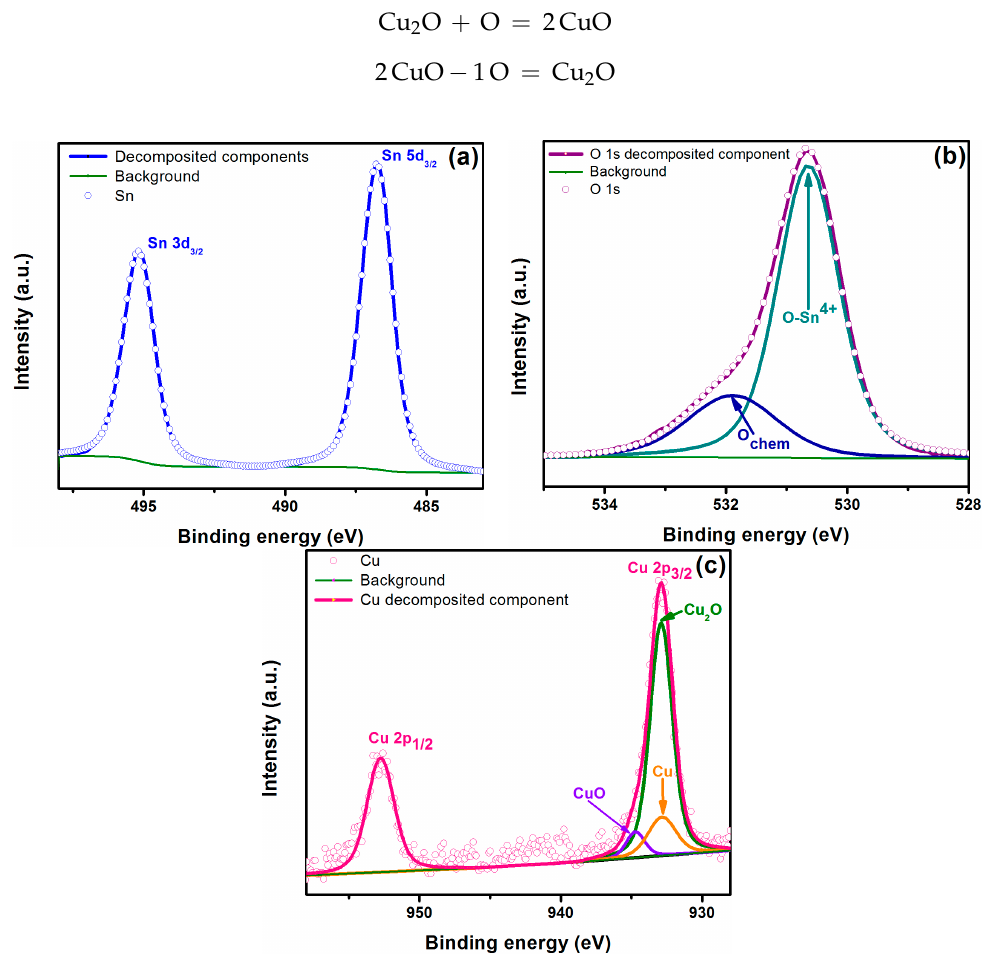
Figure 5. XPS spectra of Cu-doped SnO2 pellet surface: ( a ) Sn 3d; ( b ) O 1s; and ( c ) Cu